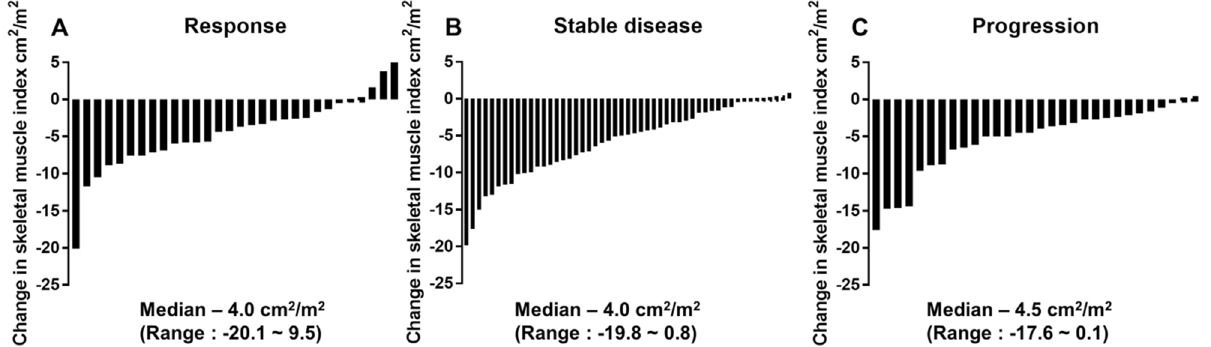
Figure. 2. Change in skeletal muscle index according to response to